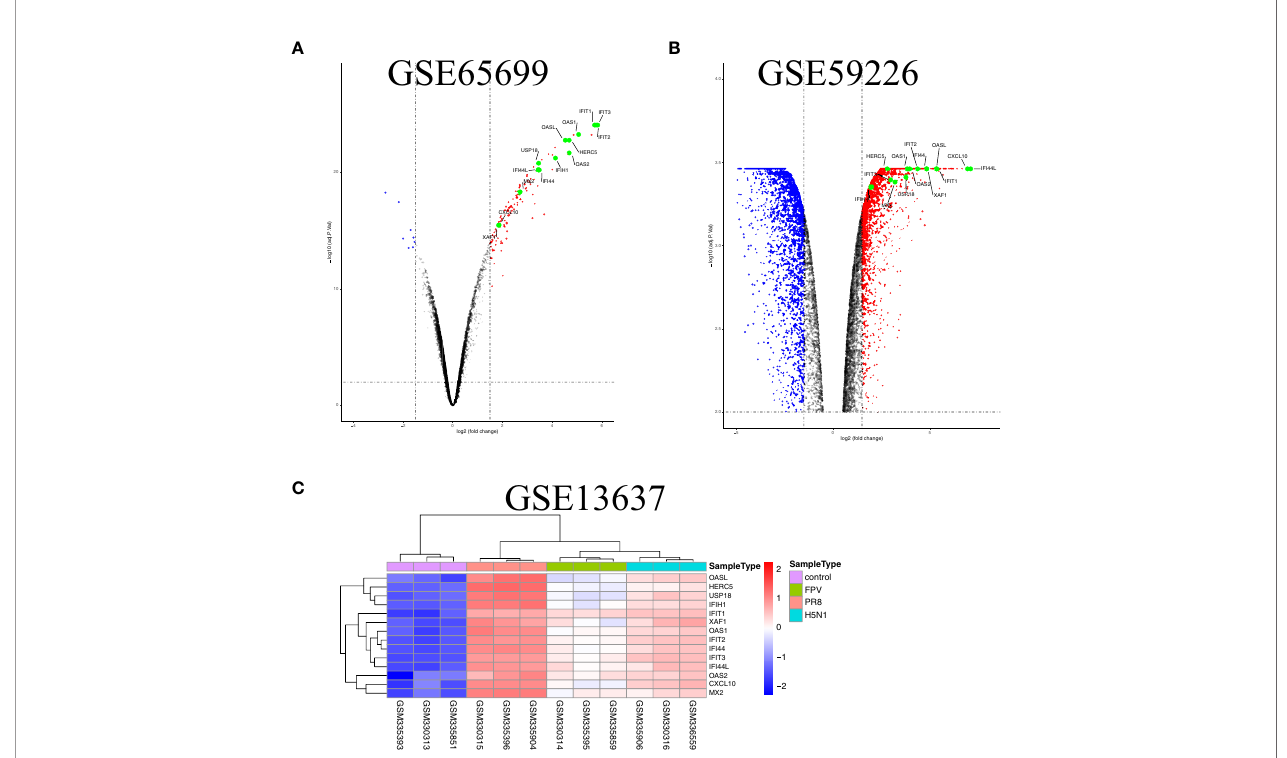
FIGURE 6 | The overlap regulation gene expression of epithelium and endothelial cells lines in response to IAV infection. (A) Volcano plots of the overlaps between mock and the H1N1-infected human retinal pigment epithelium cell line. The vertical dashed lines correspond to 1.5-fold up and down expression and the horizontal dashed line represents a p -value of 0.01. Blue and red dots indicate signi fi cantly downregulated and upregulated genes, respectively. The 13 overlapped genes identi fi ed in different IAV subtype infections are exhibited in the Volcano plots. (B) Volcano plots of the overlaps between mock and H9N2-infected human umbilical vein endothelial cells. The vertical dashed lines correspond to 1.5-fold up and down expression and the horizontal dashed line represents a p -value of 0.01. Blue and red dots indicate signi fi cantly downregulated and upregulated genes, respectively. The 13 overlapped genes identi fi ed in different IAV subtype infections are exhibited in the Volcano plots. (C) Heatmap of the overlaps in mock or H1N1, H5N1, and H7N7-infected human umbilical vein endothelial cells. Row represents the overlap genes and each column corresponds to a sample.